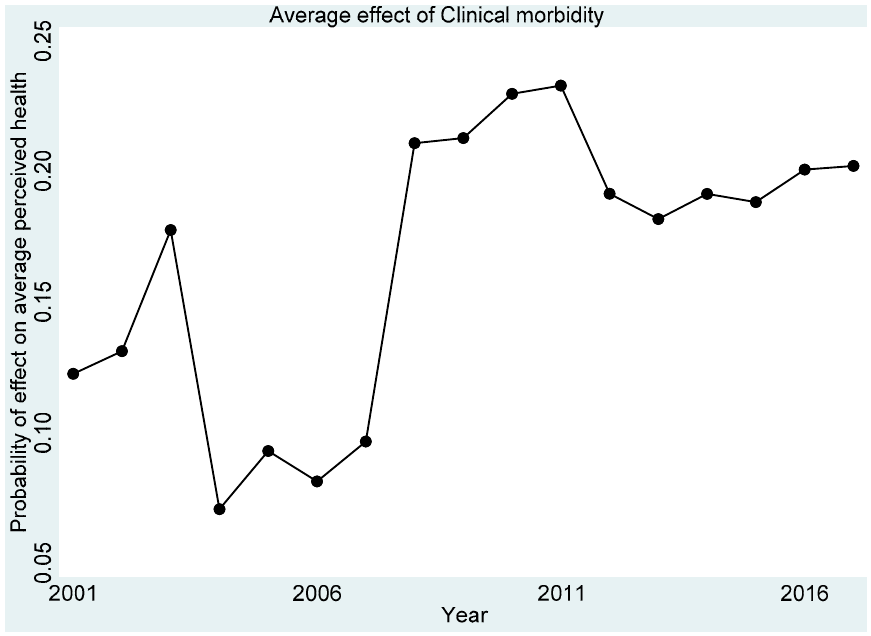
Figure 3. Probability of effects on “average” perceived health from the average effect of clinical morbidity.